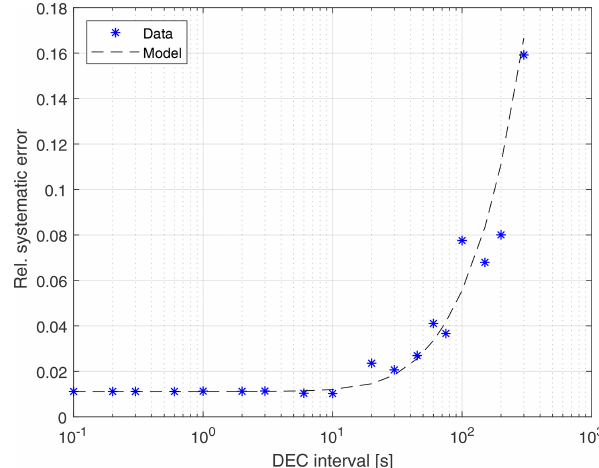
Figure 4. Systematic error of toluene flux with increasing DEC sampling interval (cid:49)t determined by artificially created DEC datasets and according to Lenschow et al. (1994).